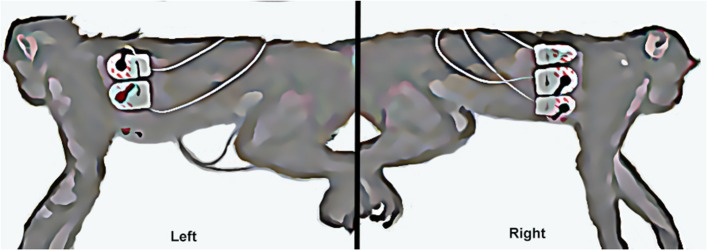
The left picture shows the left sided attachment of electrodes and ECG leads (left arm and left leg leads). The right picture shows the right sided attachment of electrodes and ECG leads (right arm, chest, and right leg leads).